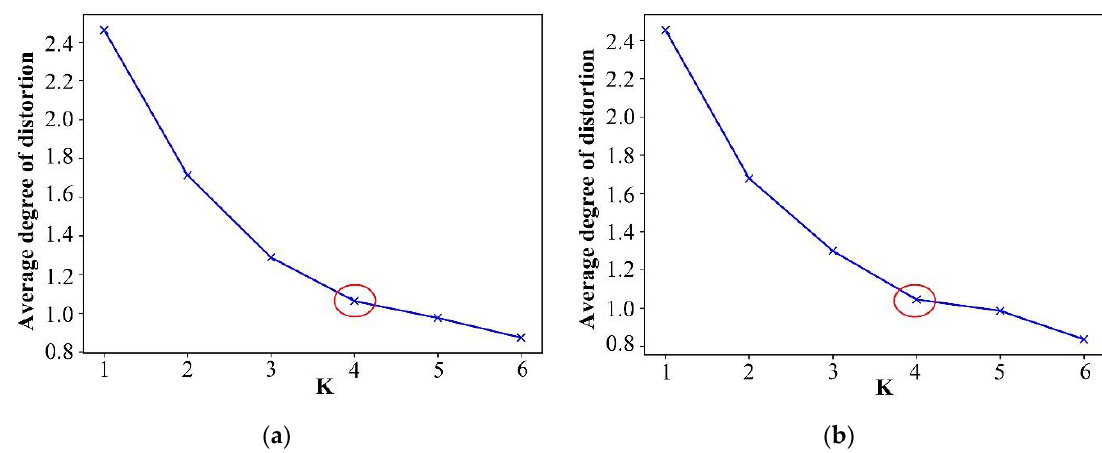
Figure 6. Best “K” value by the elbow rule. ( a ) Ideal “K” value on weekdays; ( b ) Ideal “K” value on weekends.